Question: Does the plotted quantity increase or decrease?
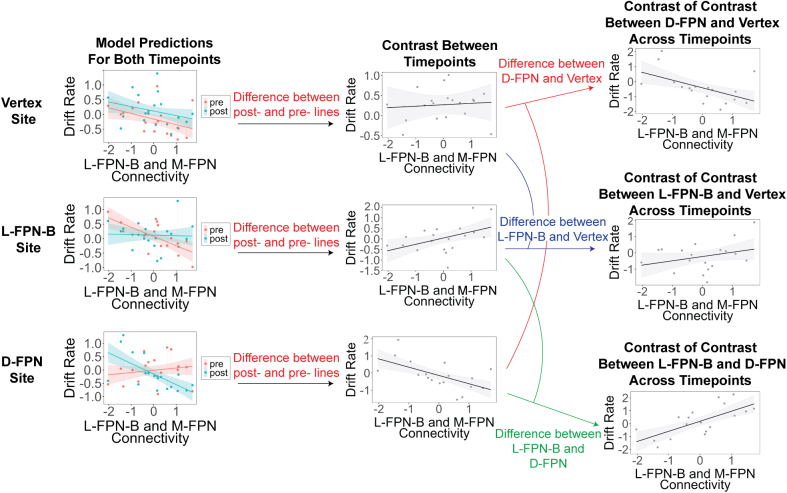
Answer: increasing